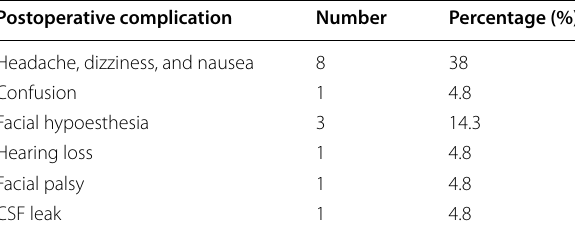
Table 4 Postoperative complications of patients after MVD Postoperative